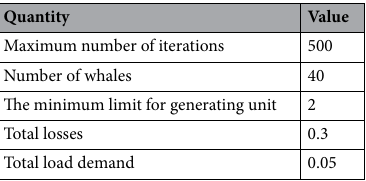
Table 1. The optimal parameters of WOA.